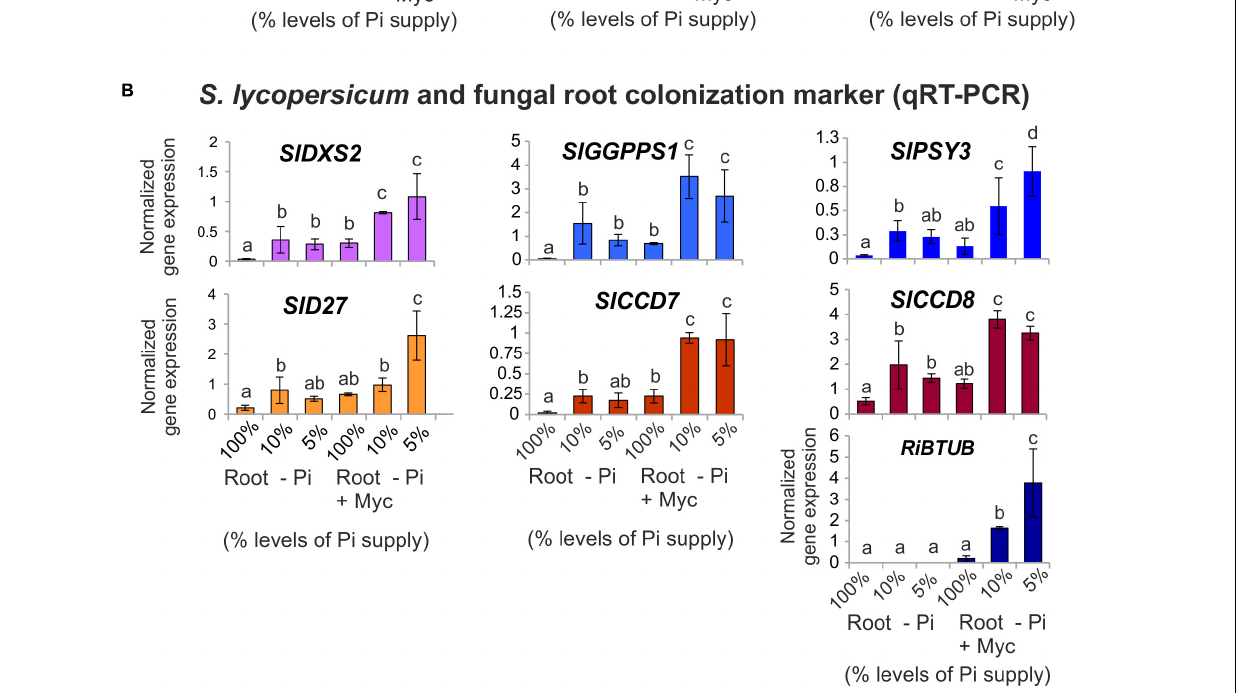
Frontiers in Plant Science |